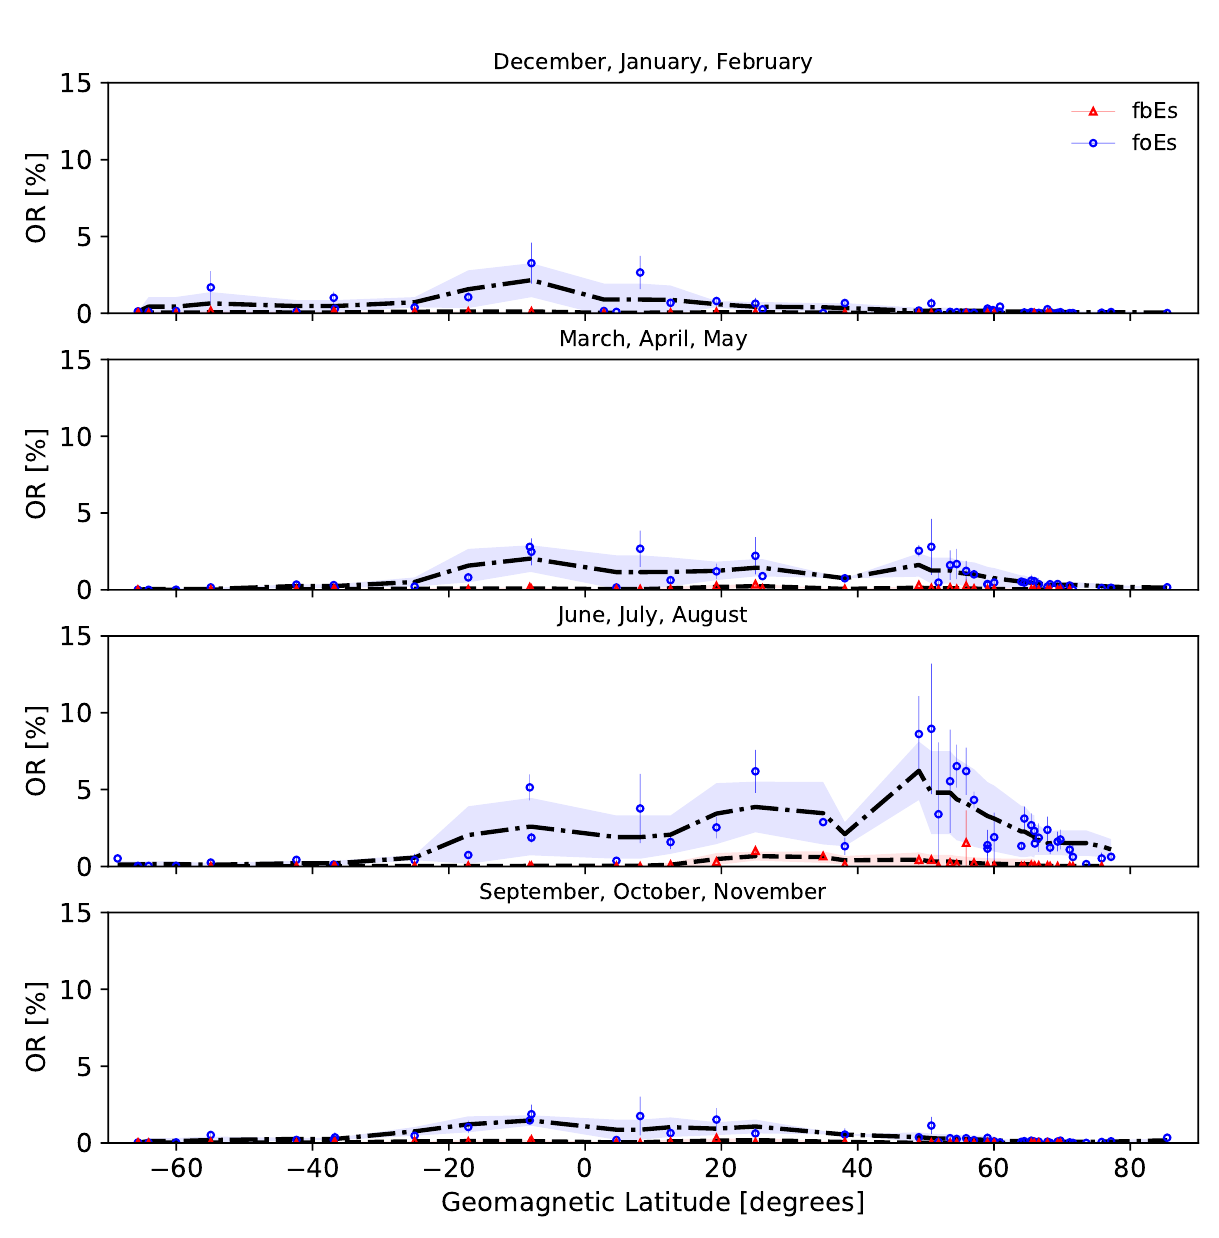
Figure 9. Occurrence rates for fbEs and foEs ≥ 7 MHz separated by geomagnetic latitude. Error bars correspond to the standard deviation of the yearly averages taken over all years with sufficient data. The trend lines and shading correspond to spatial running averages and standard deviations calculated with a ± 10 ◦ window,